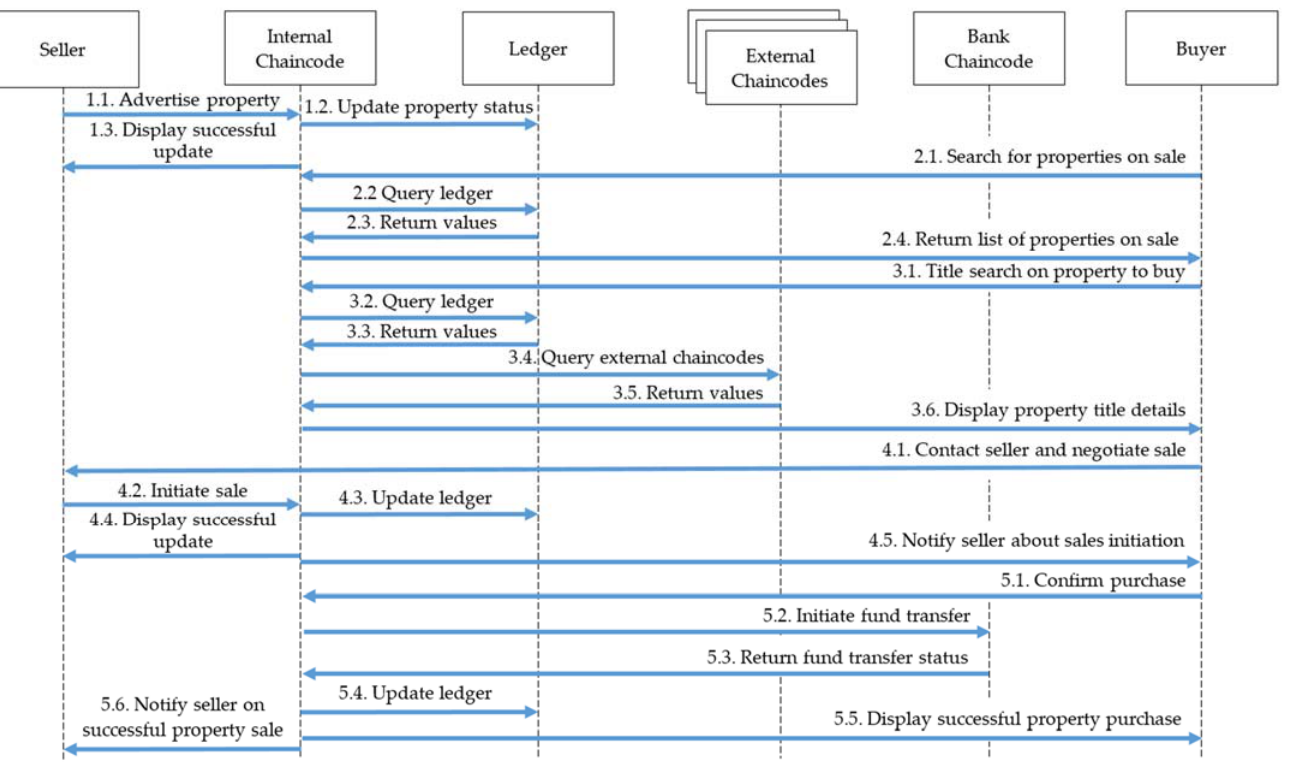
Figure 7. Process sequence for a successful property transaction through the blockchain prototype.